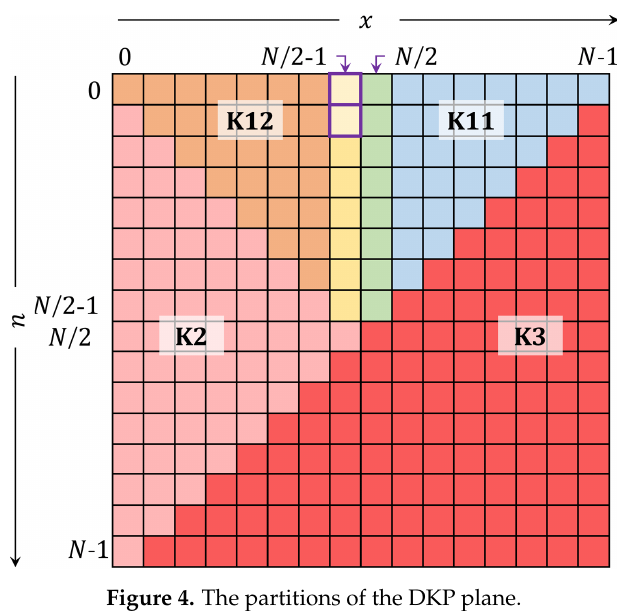
Figure 4. The partitions of the DKP plane.